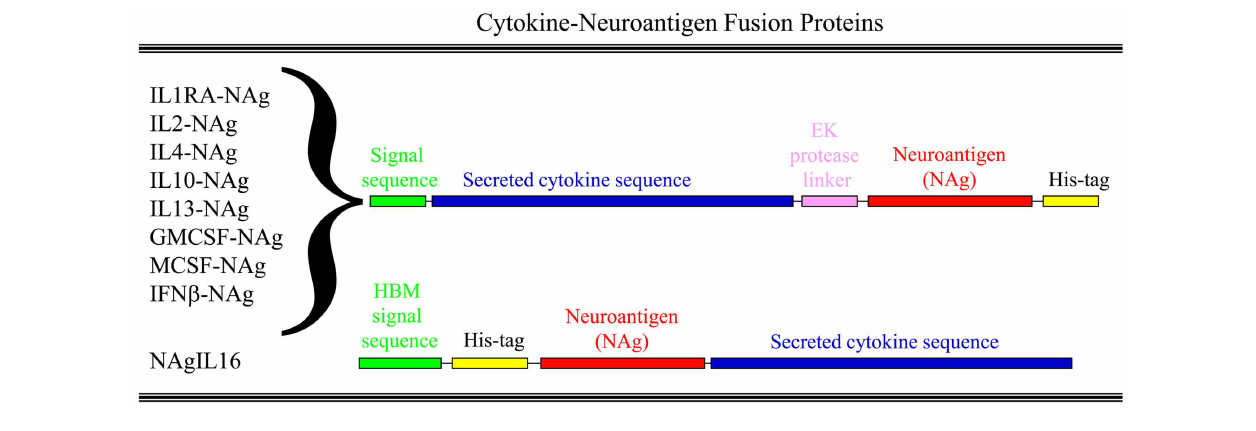
the N-terminus or IL-16 as the C-terminus. Some fusion proteins, as discussed in the Table 1 legend, contained an enterokinase (EK) linker sequence.